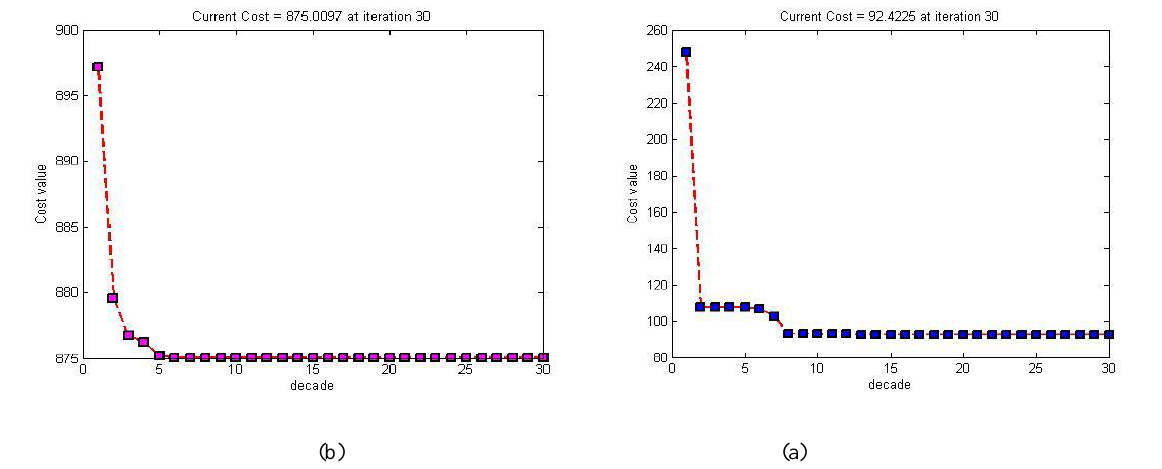
Figure 12. The convergence diagrams of the NLICA algorithm in segmentation process of the Berkley test images: